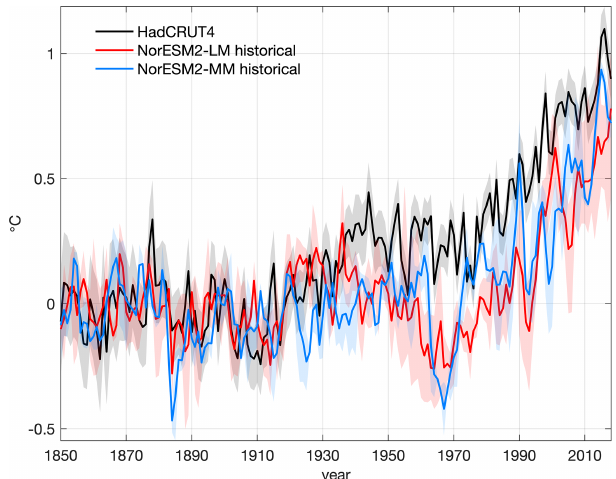
Figure 4. Time evolution of globally averaged surface tempera- ture in the historical simulations of NorESM2-LM (red line) and NorESM2-MM (blue line) shown with the observations (black line) from the Hadley Centre – Climate Research Unit Temperature dataset version 4 (HadCRUT4) (Morice et al., 2012) updated to version HadCRUT4.6.0.0. Temperatures are computed as anomalies from the time mean over the years 1850–1880. For NorESM2-LM and NorESM2-MM, the solid lines show the mean and the shad- ing of corresponding colour the spread from three ensemble mem- bers. For HadCRUT4, the solid black line shows the median and the grey shading indicates the lower and upper bounds of the 95% confidence interval of the combined effects of all the uncertainties described in the HadCRUT4 error model (measurement and sam- pling, bias, and coverage uncertainties).